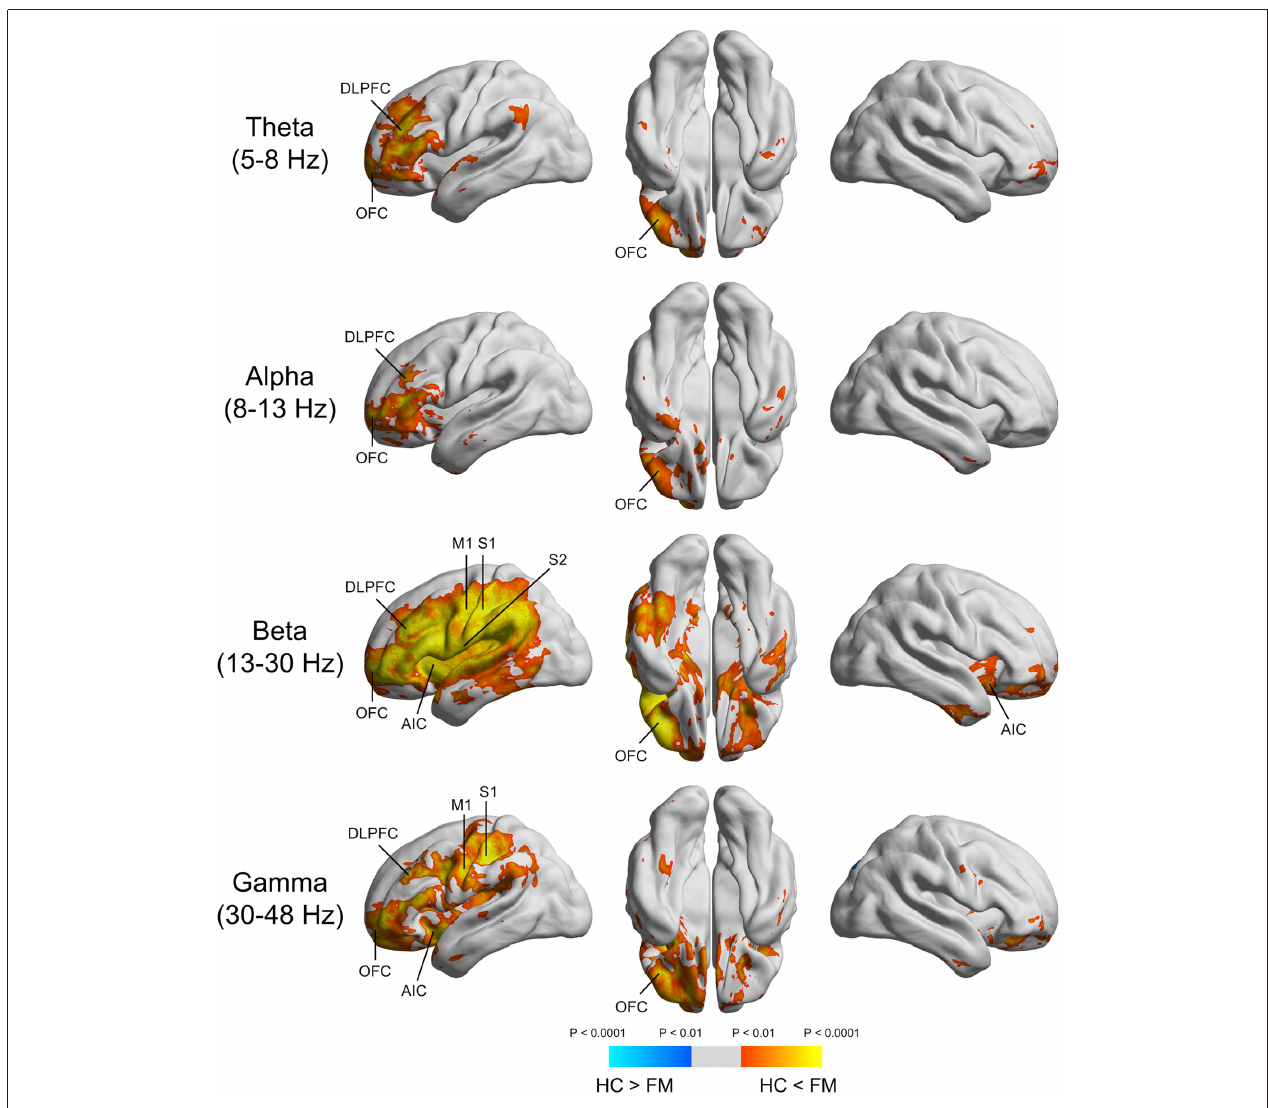
FIGURE 2 | Source imaging of the significant power differences in various frequency bands between FM patients and HC subjects . DLPFC, dorsolateral prefrontal cortex; OFC, orbitofrontal cortex; AIC, anterior insular cortex; M1, primary motor cortex; S1, primary somatosensory cortex; S2, secondary somatosensory